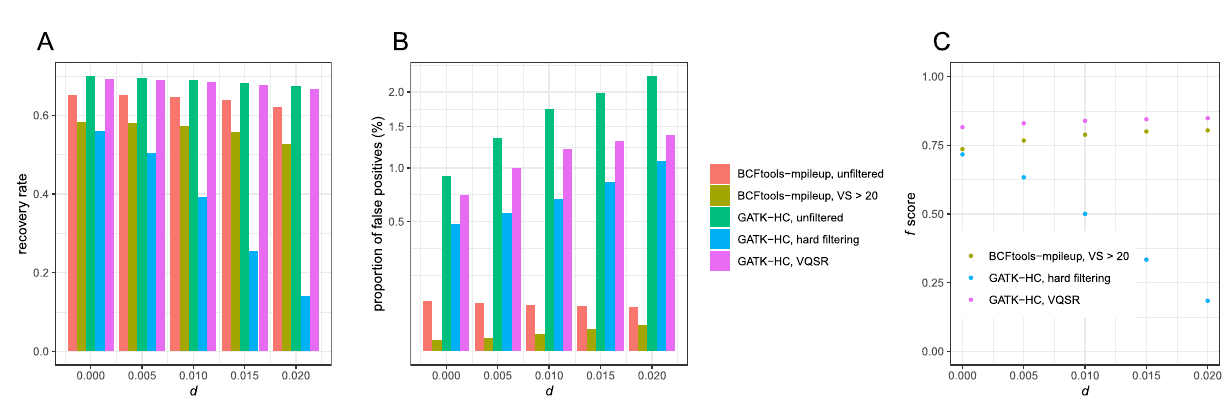
Figure 6. Variant calling performance from low coverage data ( A ) The recovery rate, ( B ) the proportion of false positives, and ( C ) f scores of SNV datasets generated by Bcftools or